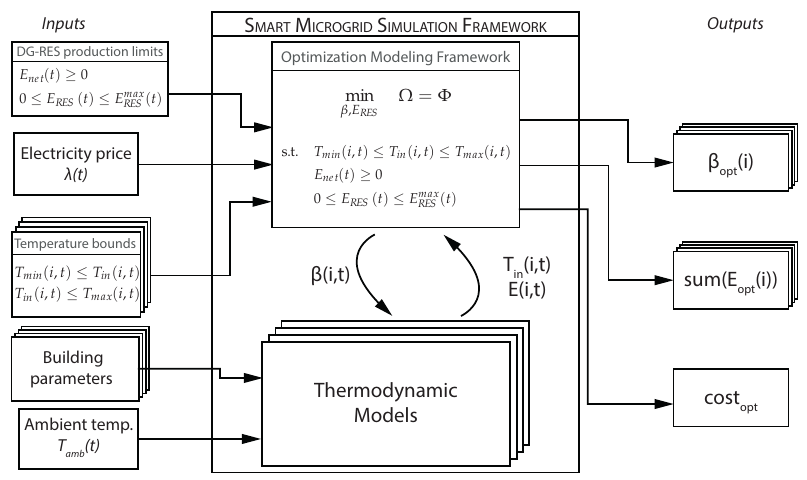
Figure 2. Smart microgrid simulation framework: interactions between the physical model and the optimization framework.